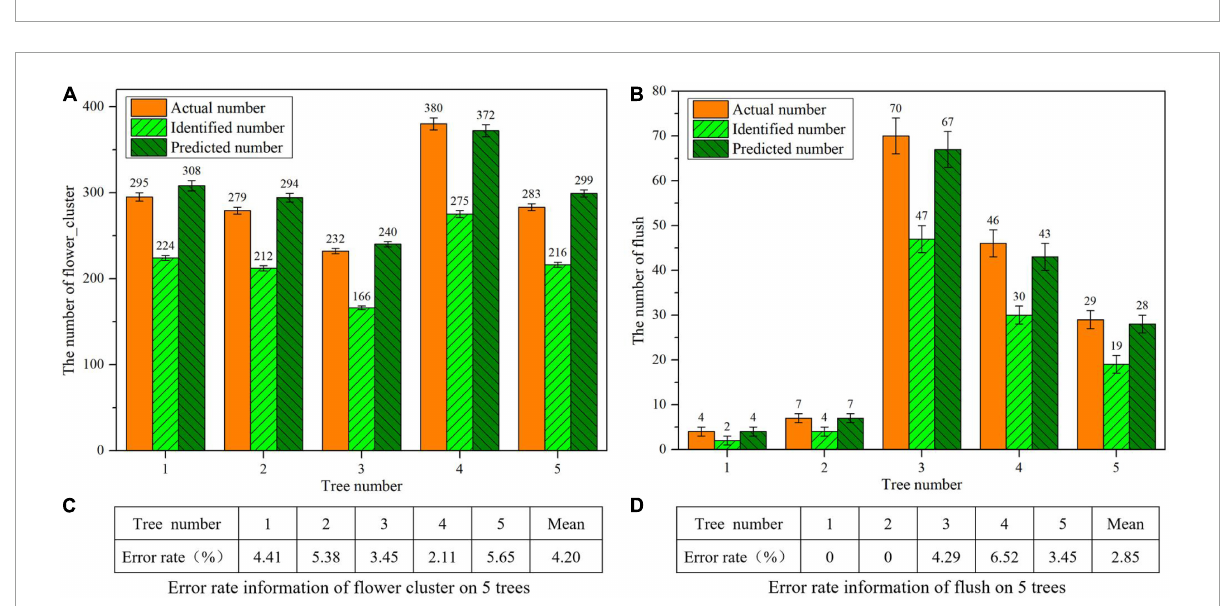
FIGURE11 Statistical information of the flower clusters and flushes of 5 litchi trees. (A) Statistical information of the flower clusters. (B) Statistical information of the flushes. (C) Error rates of flower clusters. (D) Error rates of flushes.